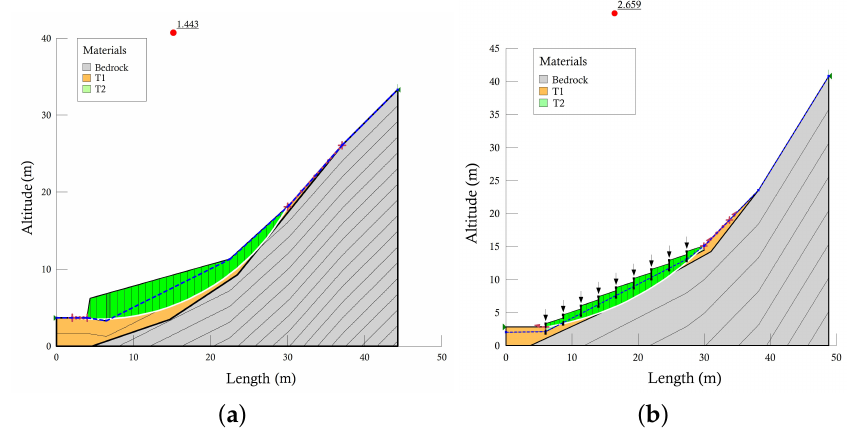
Figure 15. Stability conditions for S1 ( a ) and S2 ( b ), after the stabilization works.